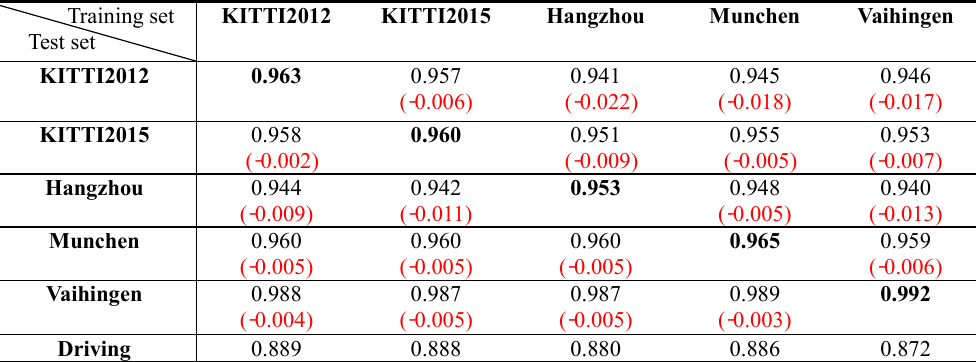
Table 1. Test results (parallax error < 3pixels considered a correct match) on the different training datasets based on MC-CNN. The numbers in bracket are the difference between the current number and the diagonal number of the current row, indicating the decreasing degree of accuracy when training with extern dataset.